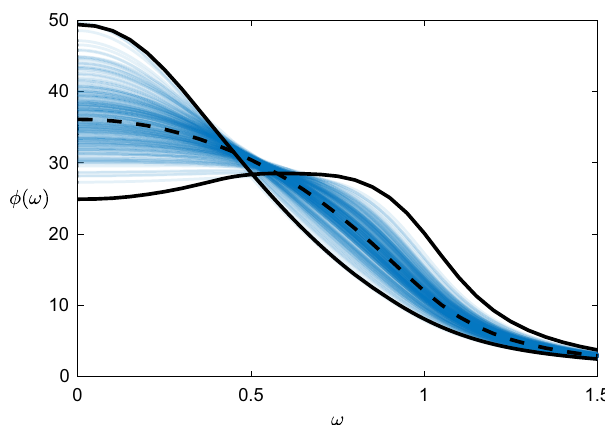
Fig. 3 Heterogeneity in species fl uctuations. Thin lines show power spectral densities for individual species in a predator-prey ecosystem model, computed using the single-defect approximation of Eq. (10). Thick lines show the power spectral density for comparison the two species with extremal fl uctuations at low frequency, computed directly via Eq. (17); the dashed line shows the mean power spectral density. Parameters are: N